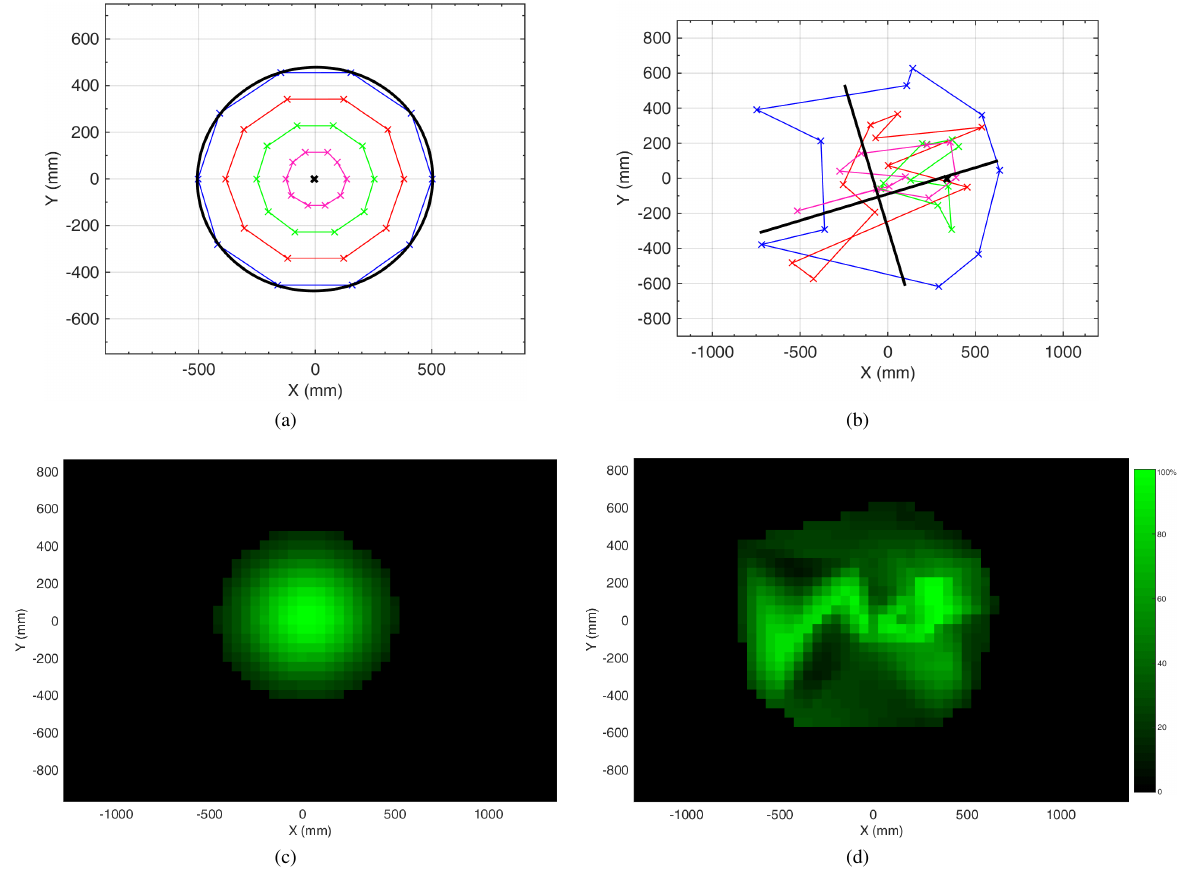
Figure 4: Wave-induced changes in laser beam’s size and shape: (a,c) Laser footprint at the water surface Υ 1 ; 959 mm × 1010 mm; almost ideal Gaussian intensity profile. (b,d) Laser footprint at the water bottom in 1metre depth; 1403 mm × 1180 mm; irregular intensity distribution.